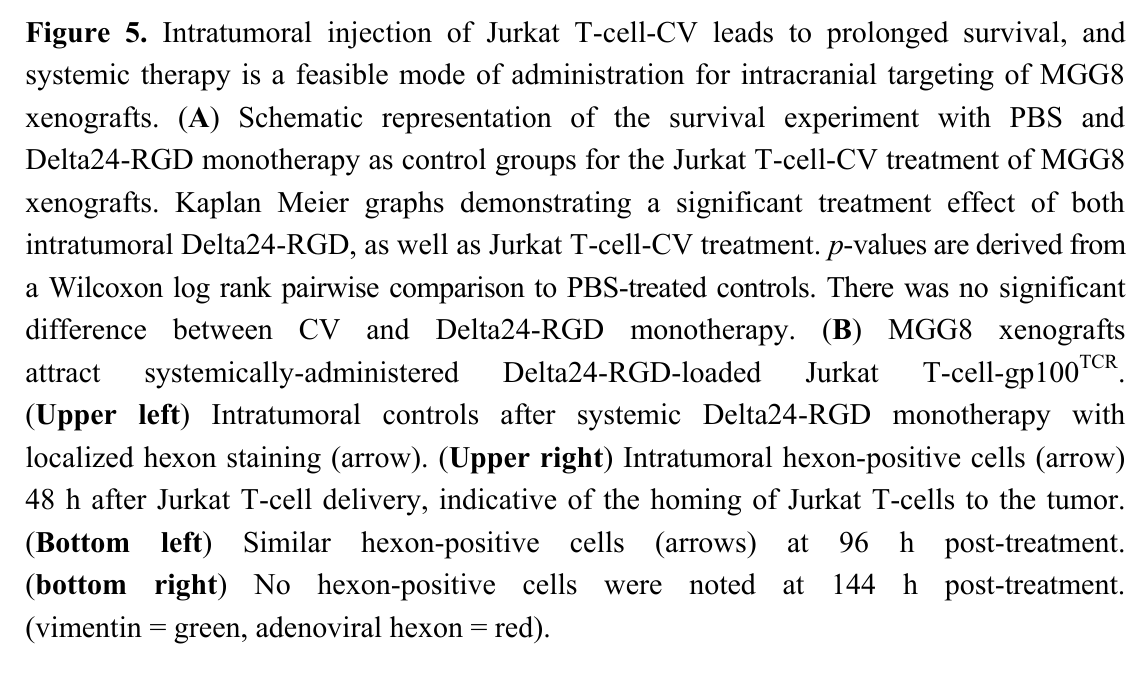
Figure 5. Intratumoral injection of Jurkat T-cell-CV leads to prolonged survival, and systemic therapy is a feasible mode of administration for intracranial targeting of MGG8 xenografts. ( A ) Schematic representation of the survival experiment with PBS and Delta24-RGD monotherapy as control groups for the Jurkat T-cell-CV treatment of MGG8 xenografts. Kaplan Meier graphs demonstrating a significant treatment effect of both intratumoral Delta24-RGD, as well as Jurkat T-cell-CV treatment. p -values are derived from a Wilcoxon log rank pairwise comparison to PBS-treated controls. There was no